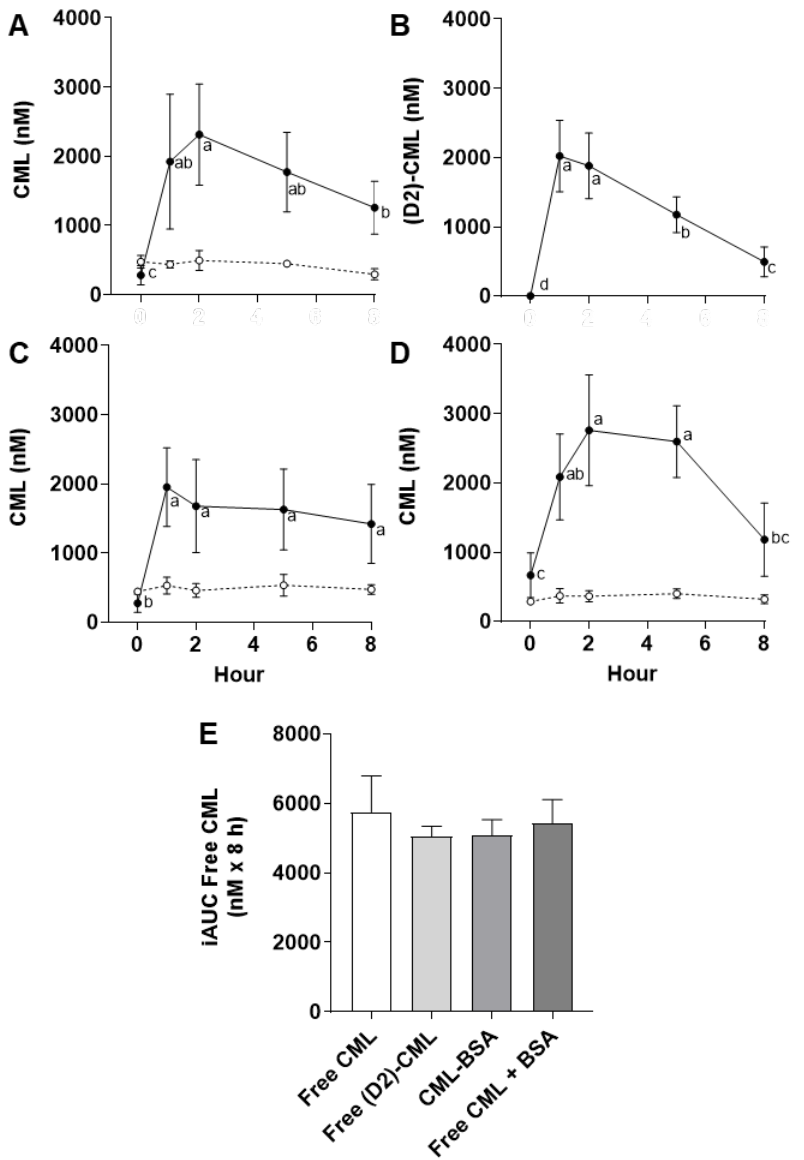
Figure 1. Kinetics of free (●) and protein-bound CML ( ○ ) in rats performed over 8 h after a single oral dose of ( A ) free CML, ( B ) free (D2)-CML, ( C ) protein-bound CML (CML-BSA), and ( D ) free CML mixed with BSA (CML + BSA). Charts shows mean ± SD values of CML concentration over time. Different letters denote statistical differences among different time points within free CML measures, taking p < 0.05 to be significant. ( E ) shows iAUC Free CML 0–8 h for ( A – D ). Bars represent mean ± SD values. No statistical significance was observed ( p < 0.05).